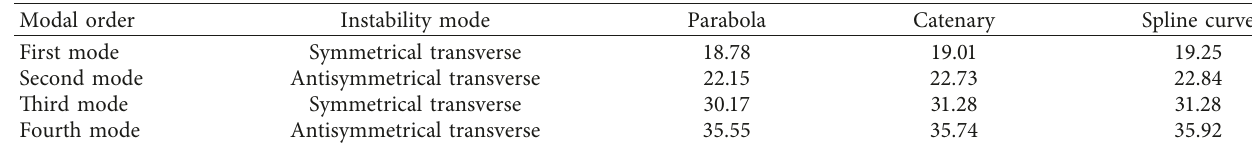
Figure 13: First four instability modes. (a) First-order instability mode. (b) Second-order instability mode. (c) Third-order instability mode. (d) Fourth-order instability mode. Table 3: Stability coefficient of the first four instability